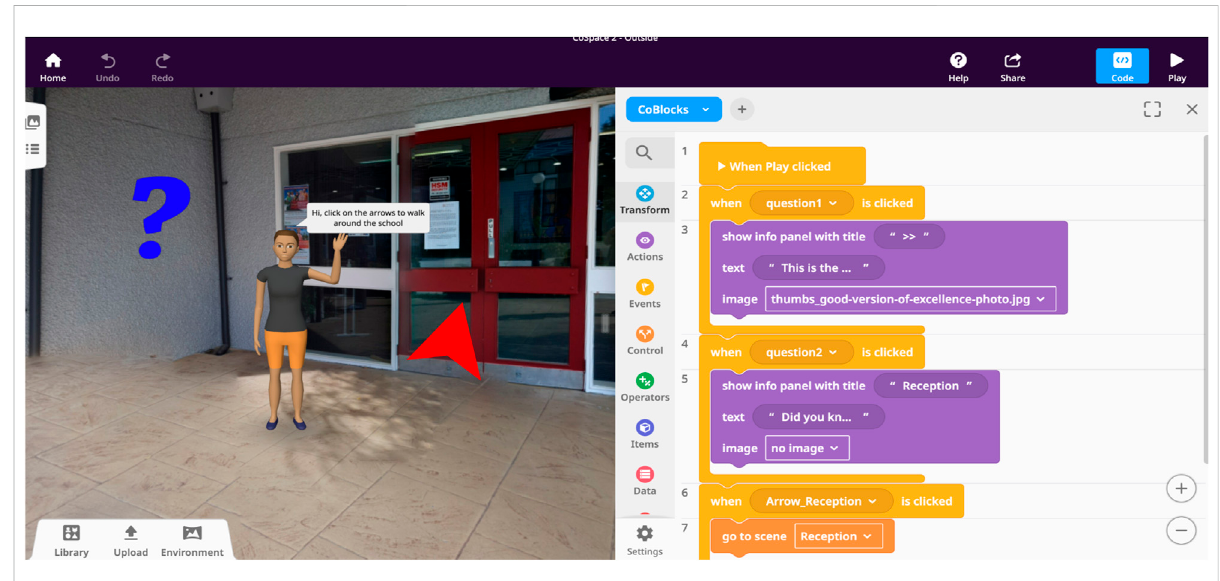
FIGURE 4 The CoSpaces studio environment where students create the interaction through block-based coding.